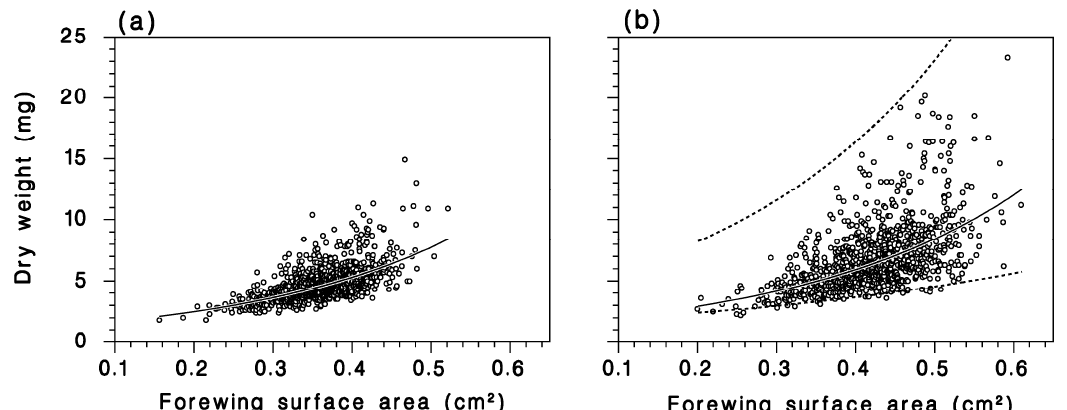
Figure 3. Relationship between dry weight (g) and forewing surface area (cm 2 ) in ( a ) male and ( b ) female spruce budworm (SBW) moths caught in canopy traps over the entire flight season at Lac des Huit-Milles, 1989–1990. Solid lines represent the fitted relationships for ( a ) males and ( b ) females, as in Equation (4). Dotted lines in ( b ) represent theoretical bounds for females based on gravidity using Equation (3).